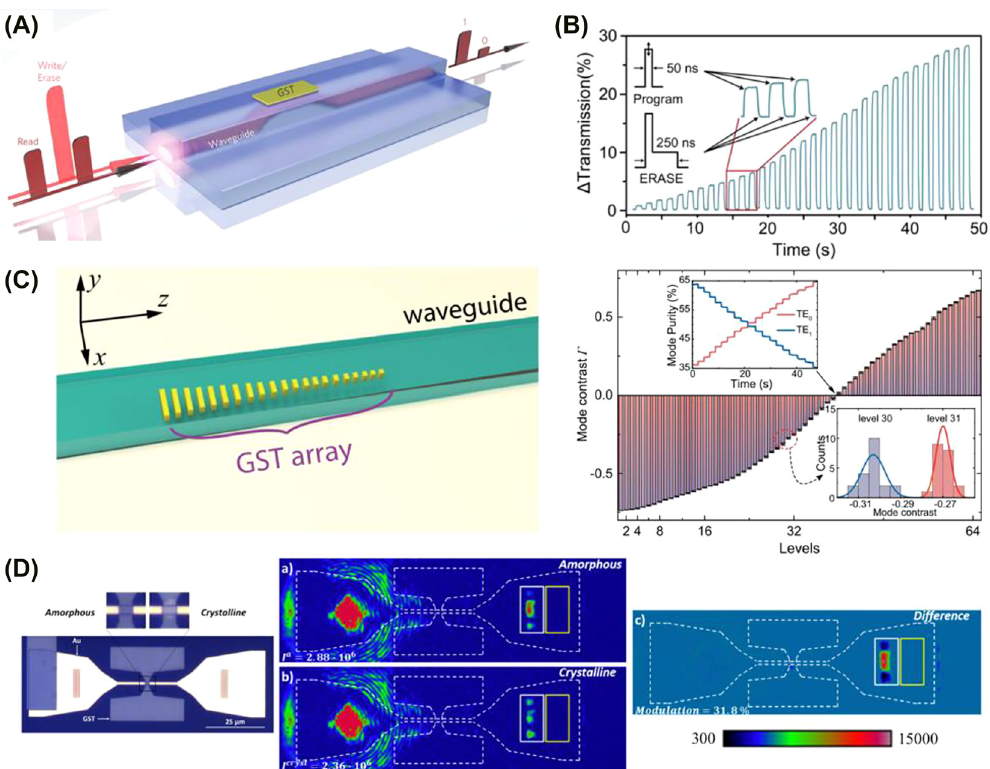
Figure 4: All-optical waveguide integrated and plasmonic PCM-based devices. (A) Device design and operation principle of an all-photonic nonvolatile memory device showing the evanescent coupling between the guided light and GST [53]. (B) Measurement of multilevel operation demonstrating over 5 bits storage capabilities [54]. (C) A multilevel programmable phase-change metasurface mode converter. Left: 3D rendering of the phase-gradient metasurface array made of GST. Right: 64 distinct levels of mode contrast corresponding to 6-bit storage accurately controlled by the mode converter [55]. (D) PCM integration in surface plasmon waveguides. Left: Optical micrograph of the plasmonic switch [60]. Middle: Intensity images showing the scattered and transmitted light when GST is (a) amorphous and (b) crystalline. Right: Contrast in the output intensity is highlighted taking the difference between (a) and (b). The PCM switching was triggered with an external laser